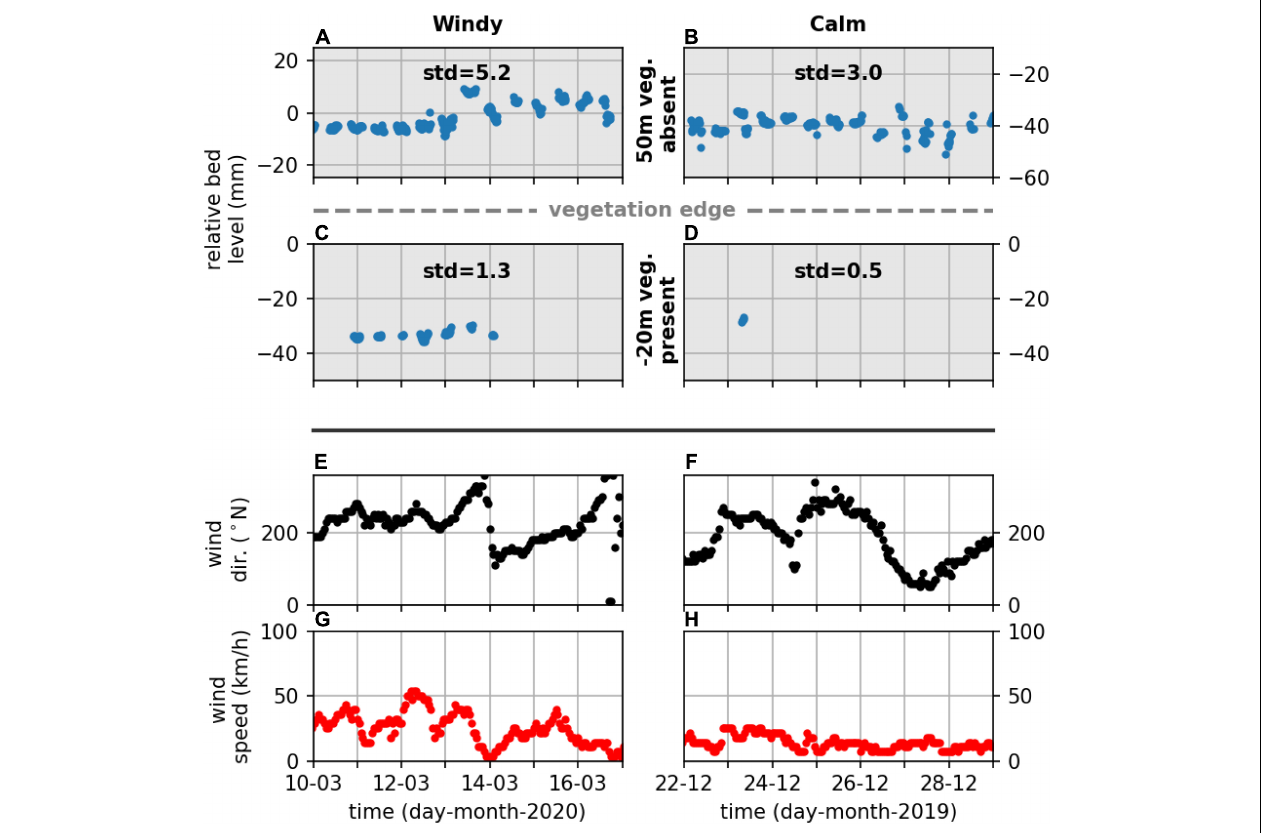
FIGURE 7 | Bed level change [ (A–D) ; blue dots], wind direction [ (E,F) ; black dots] and wind speed [ (G,H) ; red dots], during windy (left) and calm (right) wind conditions at two measurement stations at Marconi, one unvegetated and one vegetated. The standard deviation (mm) of the bed level for the represented time series is indicated (A–D)